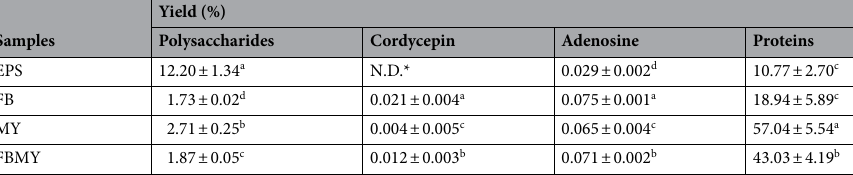
Table 1. Main components of the four C. militaris fermentation products used in this study. *N.D. means the detection result is below limit of quantitation, i.e., not detected. Panels marked with different lowercase letters are significantly different ( p < 0.05).